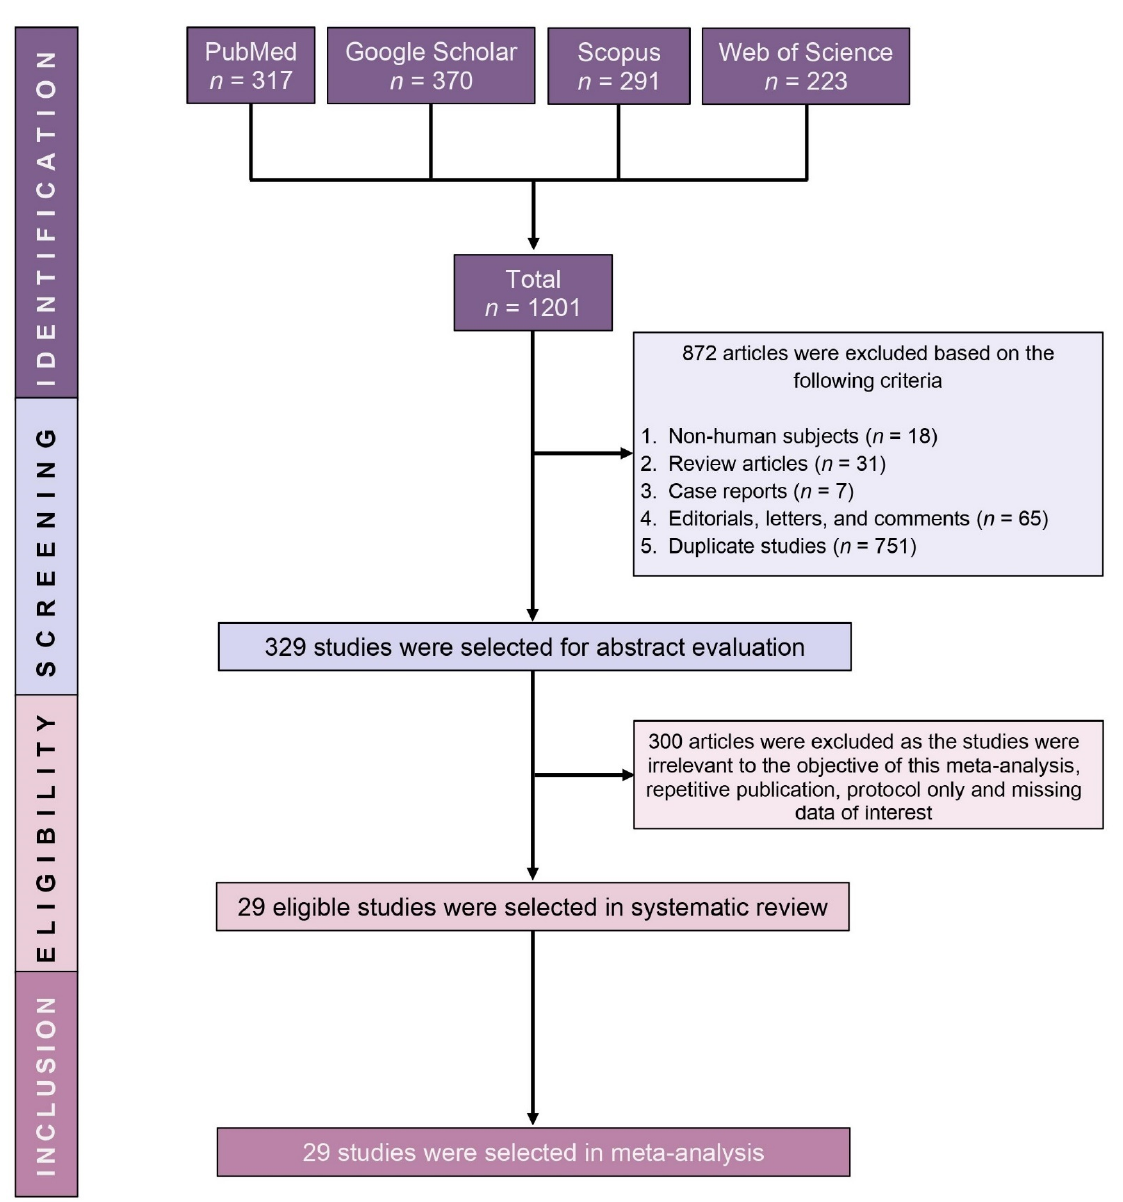
Figure 1. PRISMA flow diagram of study selection.